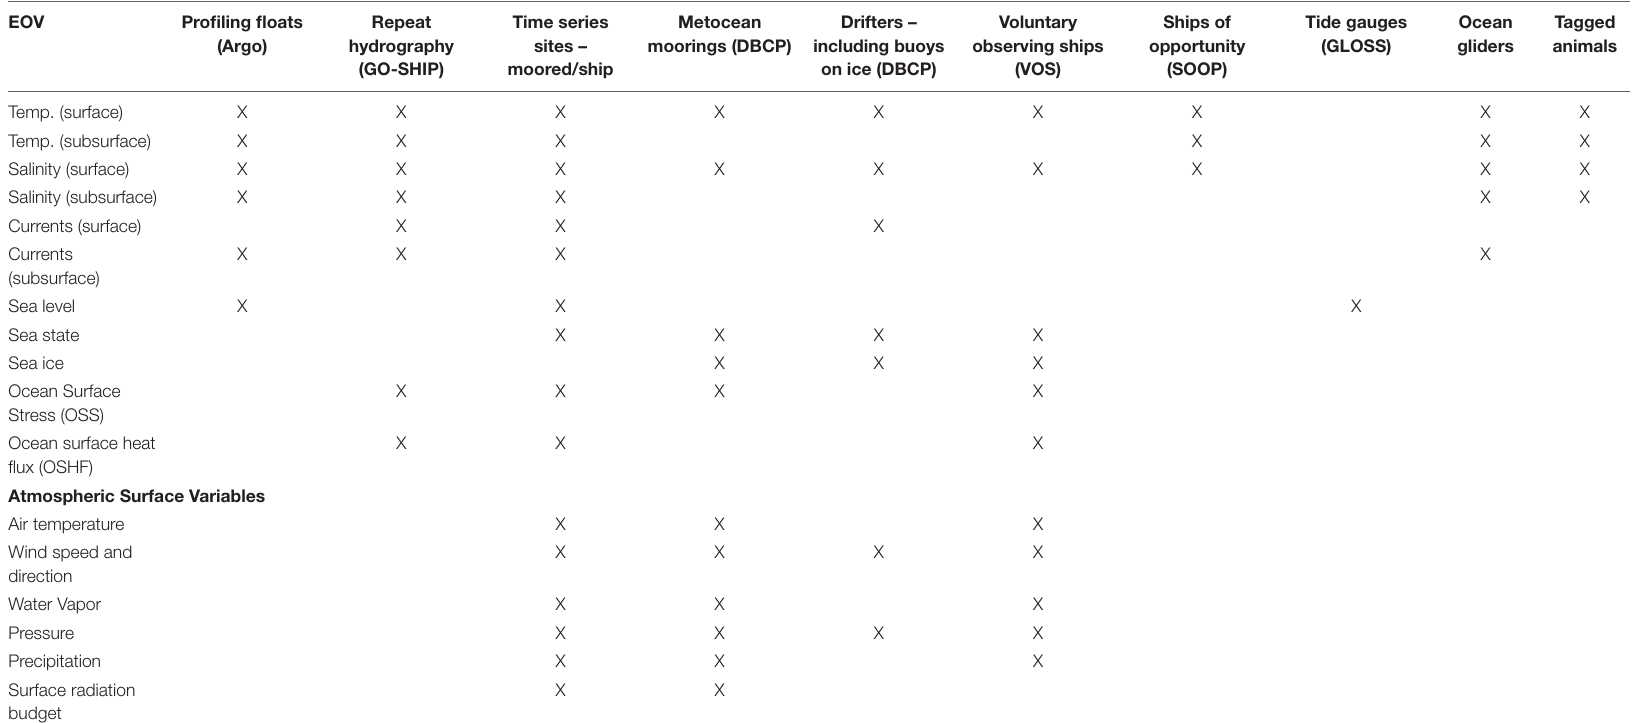
TABLE 1 | List of GOOS programs and variables they collect for ocean and atmosphere (from Sloyan et al., 2018). EOV Profiling floats Repeat Time series Metocean Drifters – Voluntary Ships of Tide gauges Ocean Tagged (Argo) hydrography sites – moorings (DBCP) including buoys observing ships opportunity (GLOSS) gliders animals (GO-SHIP) moored/ship on ice (DBCP) (VOS) (SOOP) Temp. (surface) X X X X X X X Temp. (subsurface) X X X X X X Salinity (surface) X X X X Salinity (subsurface) X X X X X Currents (surface) X X X Currents X X X X (subsurface) Sea level X X Sea state X Sea ice X X Ocean Surface X Stress (OSS) Ocean surface heat flux (OSHF) Atmospheric Surface Variables Air temperature Wind speed and X direction Water Vapor Pressure Precipitation X Surface radiation budget The global ocean observing system (Chassignet et al.,